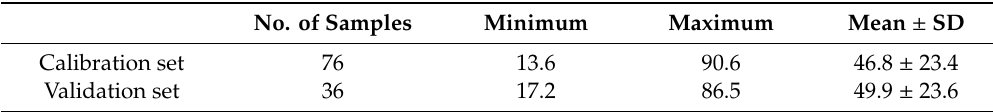
Table 2. Summary of descriptive statistics for the calibration and validation data sets (excluding number of samples, all units in